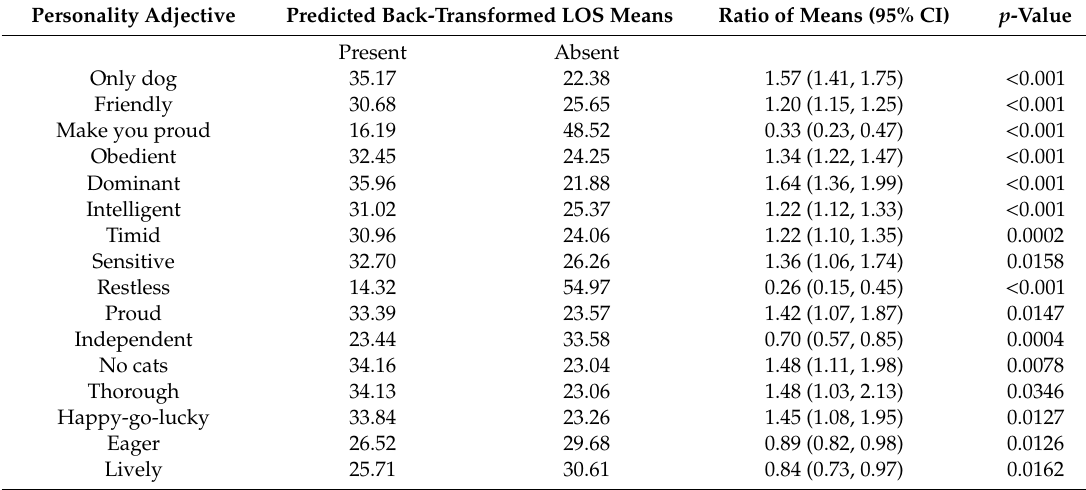
Table 5. The results of the second final multivariable model of LOS restricted to data for only the four most common breeds ( n = 20,198